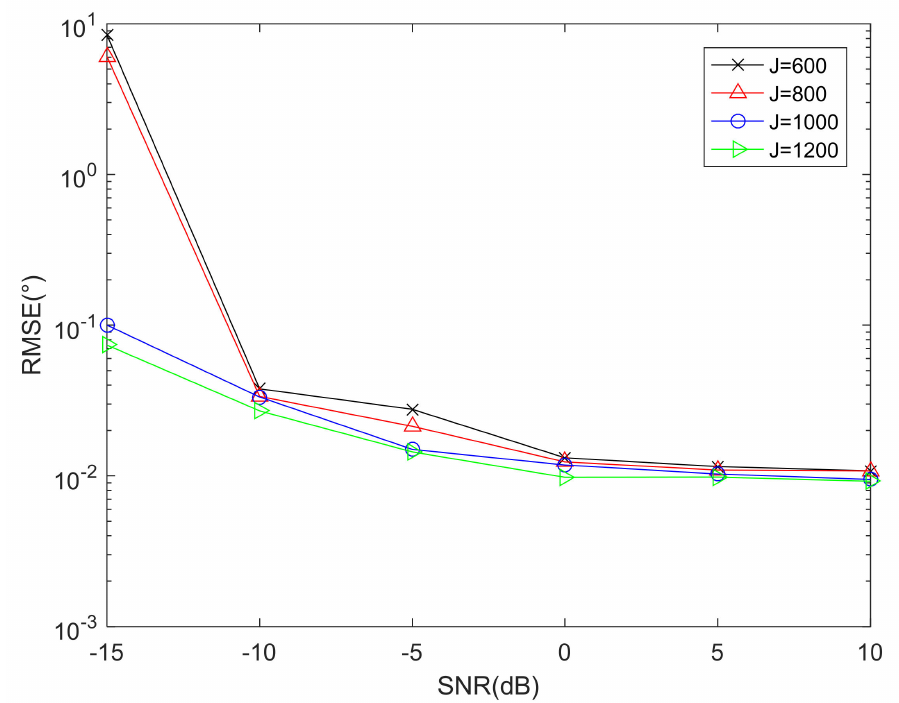
Figure 6. RMSE performance comparison versus